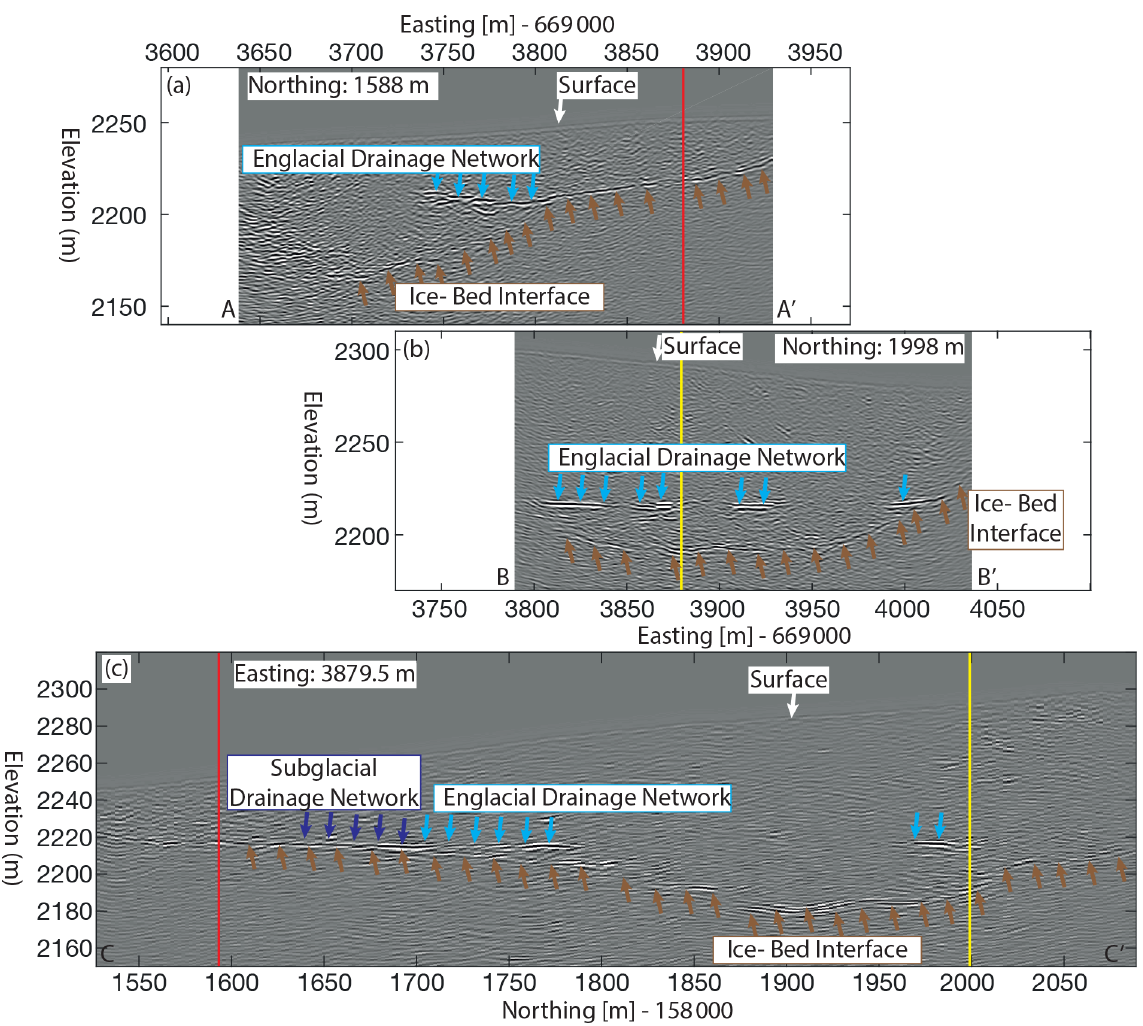
Figure 2. (a) GPR inline profile (perpendicular to ice flow direction): the glacier surface, drainage network, and basal interface are marked, and the red line represents the crossing point for profile (c) . (b) GPR inline profile (perpendicular to ice flow direction): the yellow line represents the crossing point for profile (c) . (c) GPR crossline profile (parallel to ice flow direction). The locations of the profiles are shown in Figs. 1b and